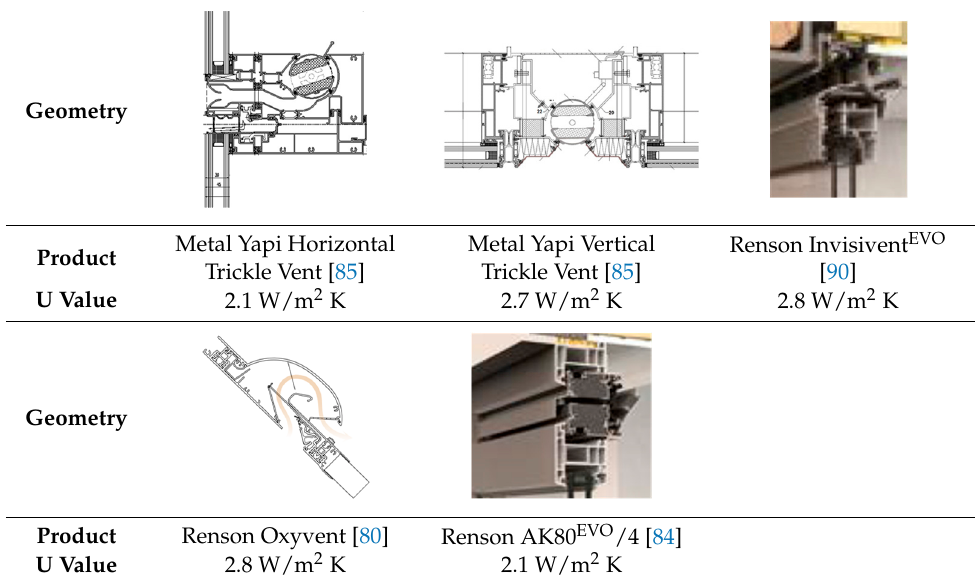
Table 8. U values of various brands in the market.